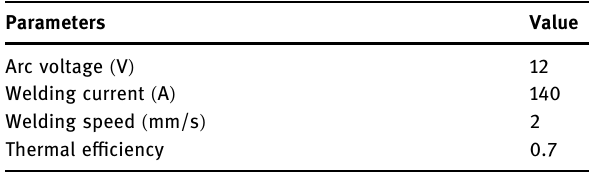
Table 1: Parameters of Nicrofer 6023H GTAW process